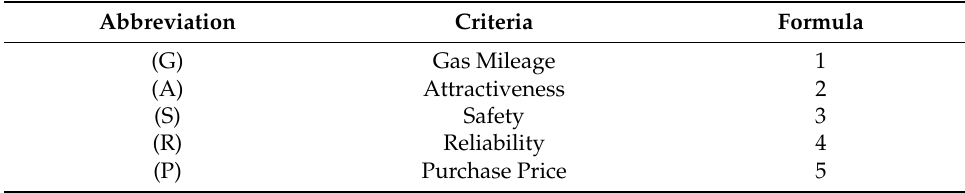
Table 3. Rank ordering of decision criteria.